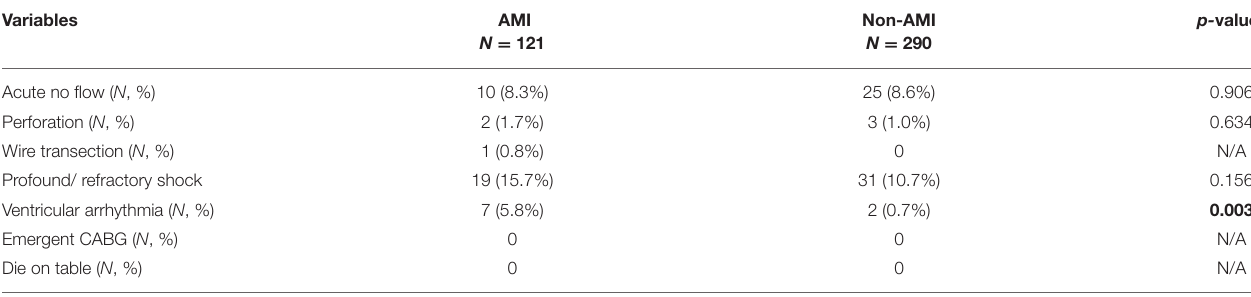
TABLE 3 | Procedure outcomes of rotational atherectomy in acute myocardial infarction (AMI) vs. non-AMI cases in the study period. Variables AMI N =